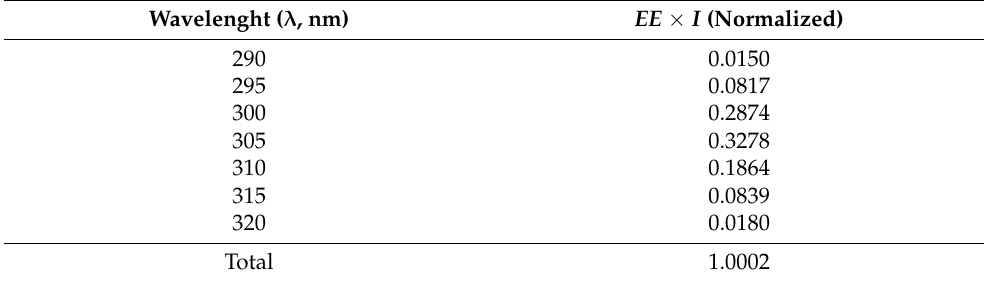
Table 5. Normalized product function used in the calculation of sun protection factor